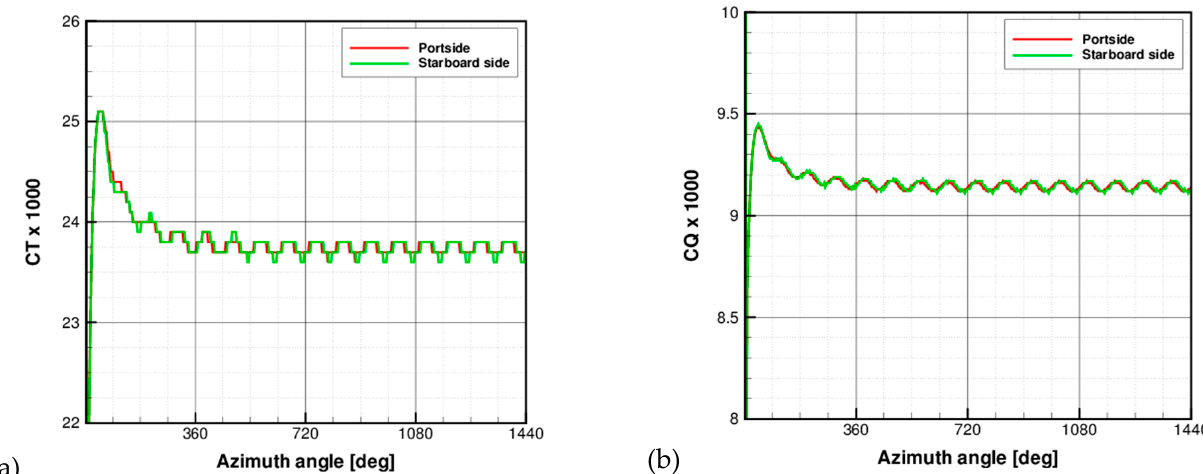
Figure 13. Configuration A—the thrust ( a ) and induced-torque ( b ) time histories in a 100%-ETR climb.